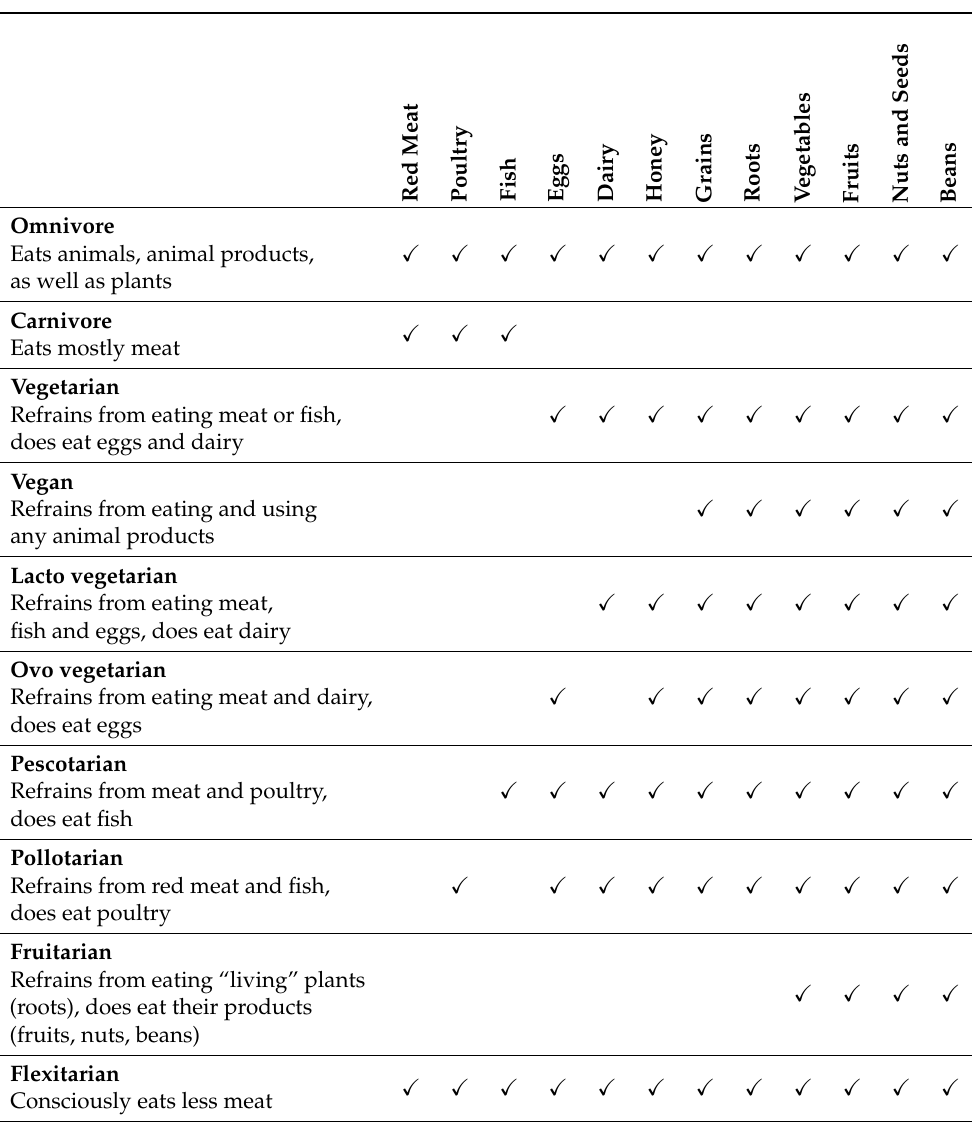
Table 2. Consumption behaviours and the way people performing it are commonly referred